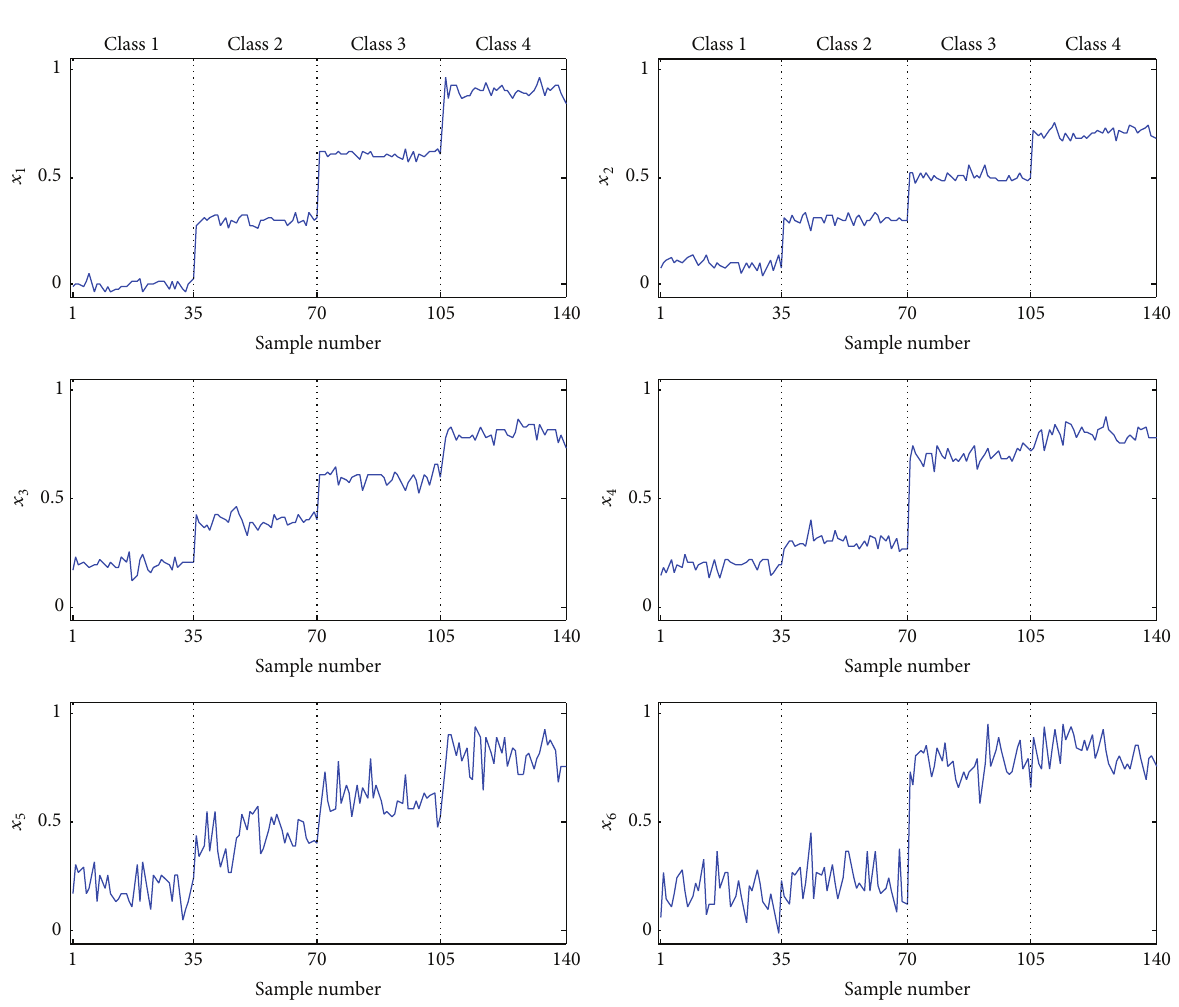
modified distance discriminant technique is superior to the original distance discriminant